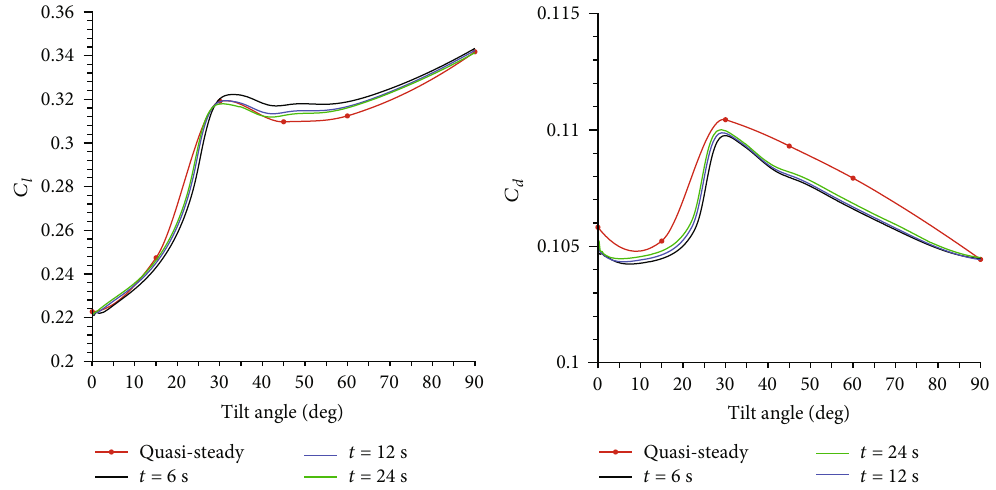
Figure 28: Unsteady aerodynamic coe ffi cients for di ff erent conversion period Figure 26; the symbol x / c on the horizontal axis represents the nondimensional airfoil chord length. It can be seen from the fi gure that at Position 1, the lowest upper surface pressure is at 30 ° , while at Position 2 and Position 3, the lowest upper surface pressure is at the tilt angle of 90 ° . At all positions, the upper surface pressure in helicopter mode is the largest.